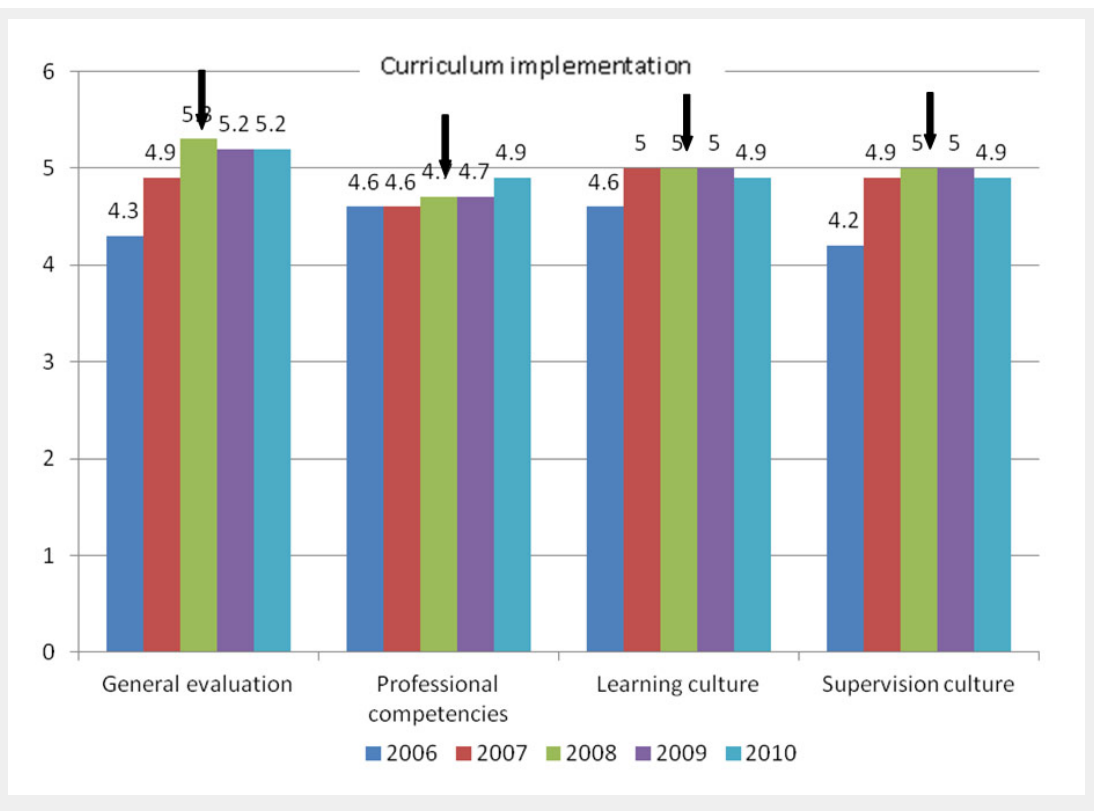
Figure 4 Residents’ global evaluation of post-graduate training in the division of primary care medicine, expressed on a Likert scale (1 to 6, 6 being the highest grade). Official FMH data. Response rate: 2007: 15/32 (47%); 2008: 20/45 (44%); 2009: 18/45 (40%); and 2010: 20/49 (41%). ↓ Arrows represent curriculum implementation. The rating was based on 6 points-Likert